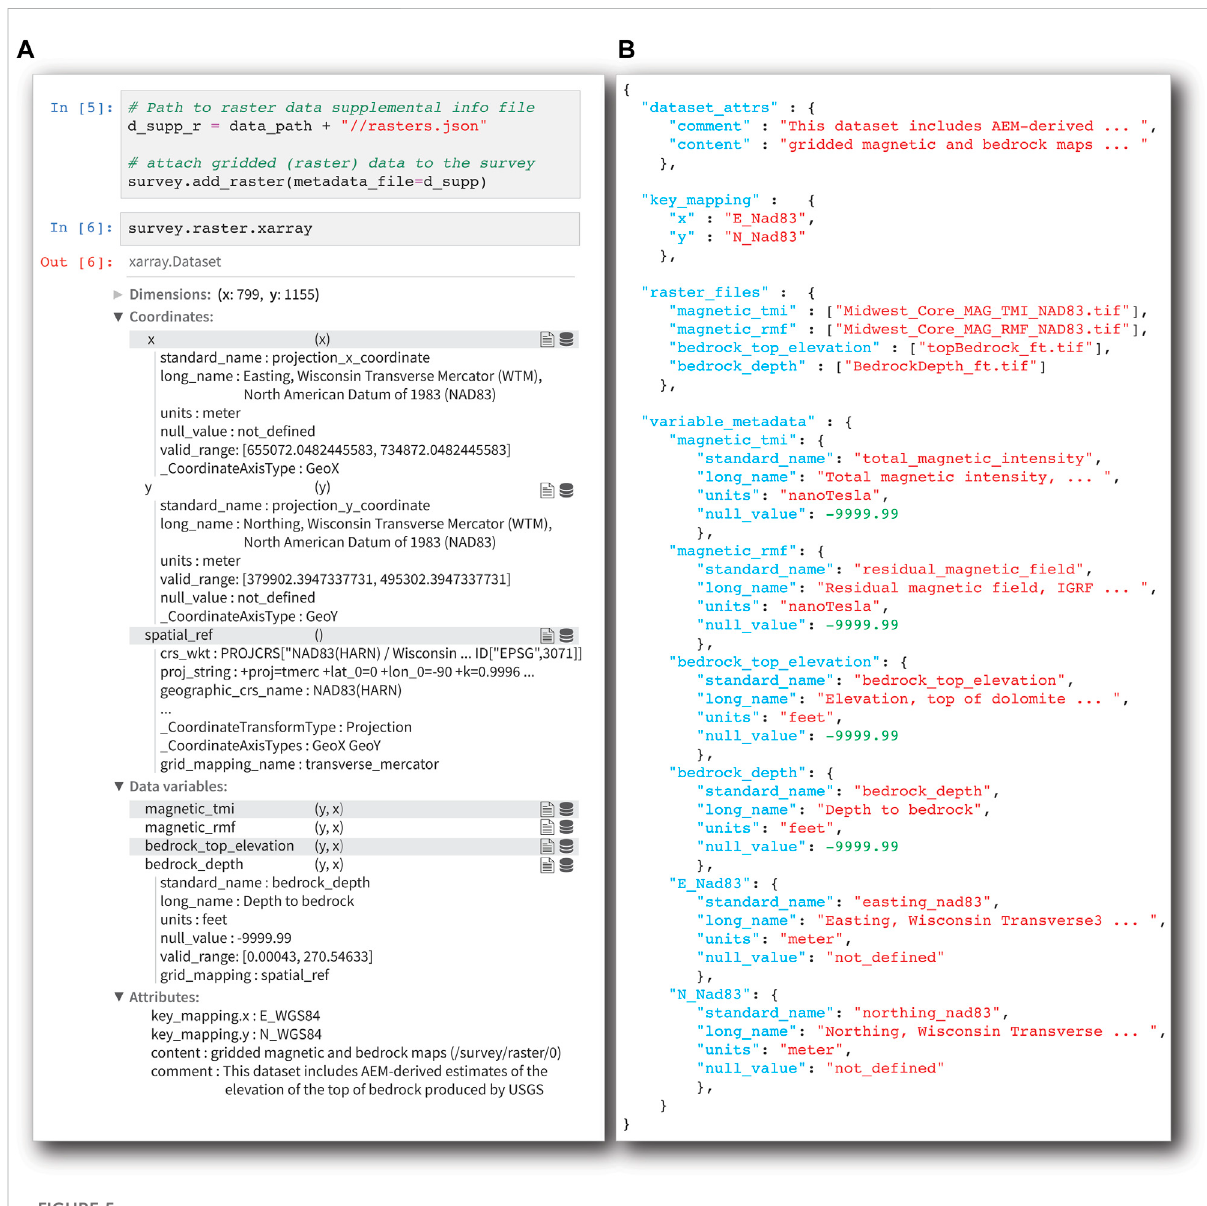
FIGURE 5 Attaching a Raster group to a Survey . (A) The “ add_raster ” method is used to add a Raster Dataset to Survey . (B) As with Tabular groups, the Dataset attributes, coordinate “ key_mapping ” , and variable-speci fi c metadata are passed through a required JSON fi le. The Raster class allows for a one-to-onemappingofGeoTIFF fi lestoDataArrayvariableswithintheDataset,ormultiple fi lescanbestackedintoasinglevariable.The “ raster_ fi les ” dictionary maps the desired variables to its input fi